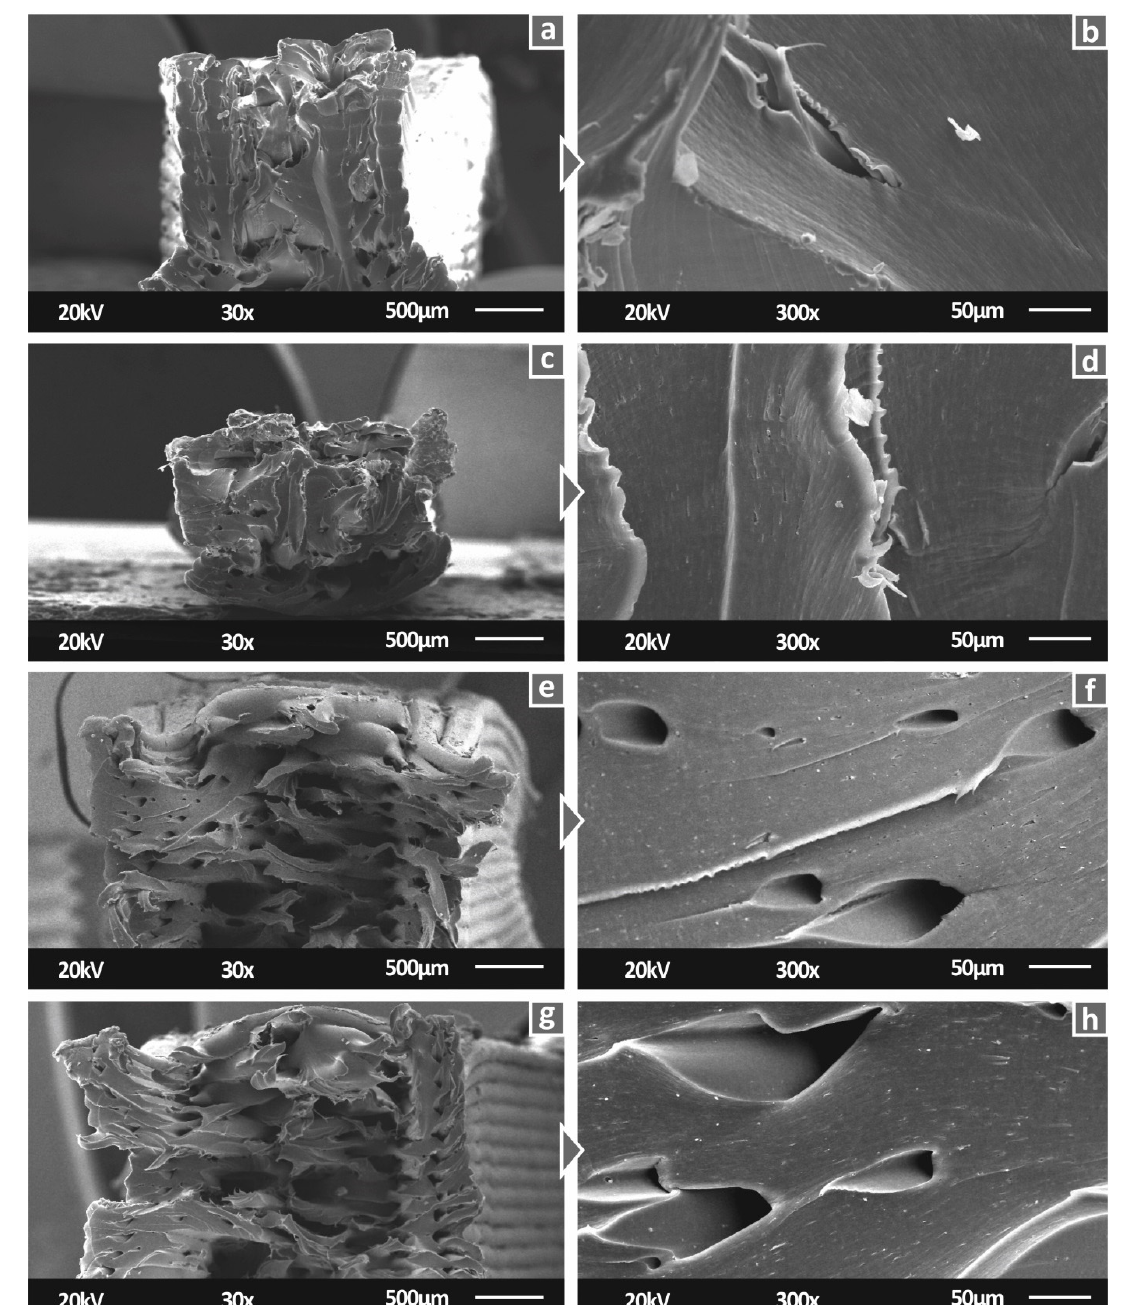
Figure 9. SEM 30× magnification images of fracture surface capture of tensile specimens for: ( a ) PA12/AgDANP 1.0 wt.%; ( c ) PA12/AgDANP 2.0 wt.%; ( e ) PA12/AgDANP 3.0 wt.%; ( g )